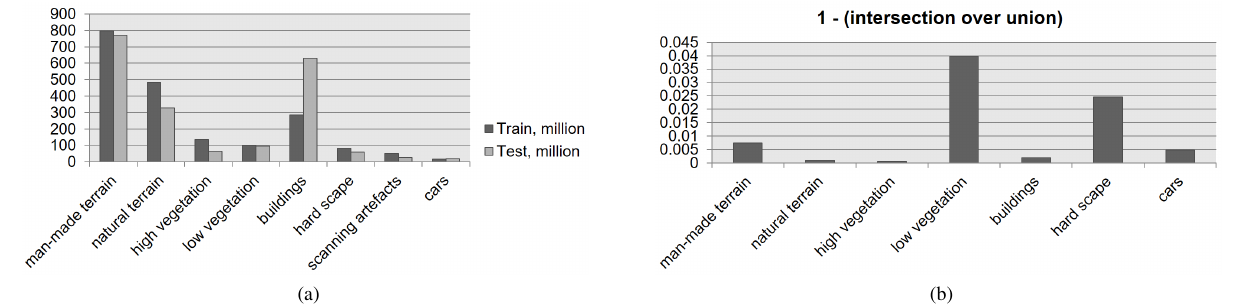
Figure 5: (a) Number of points per class over all scans and (b) ground truth label errors estimated in overlapping parts of adjacent